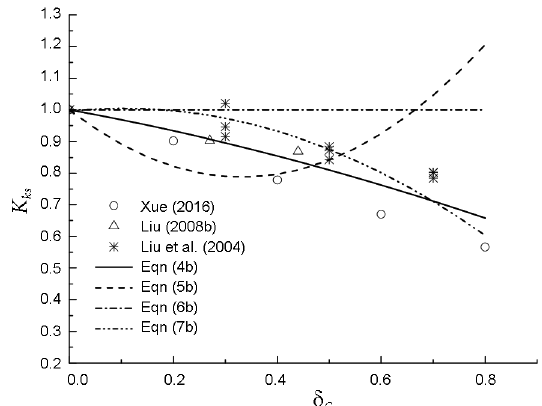
Figure 4. Comparison of computed results of K ks and experimental data under compressive